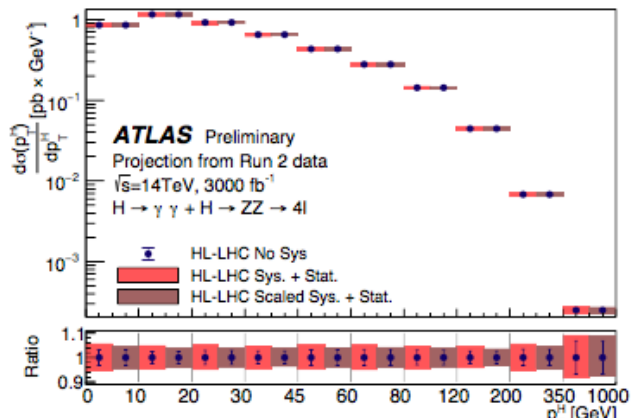
Figure 3: Differential cross sections in the total phase space extrapolated to the full HL-LHC luminosity for the combination of the H → γγ and H → ZZ ∗ → 4 (cid:96) decay channels for the Higgs boson transverse momentum p H . For each point both the T statistical (error bar) and total (shaded area) uncertainties are shown. Two scenarios are shown: one with the current Run 2 systematic uncertainties and one with reduced systematic uncertainties [ 24 ]